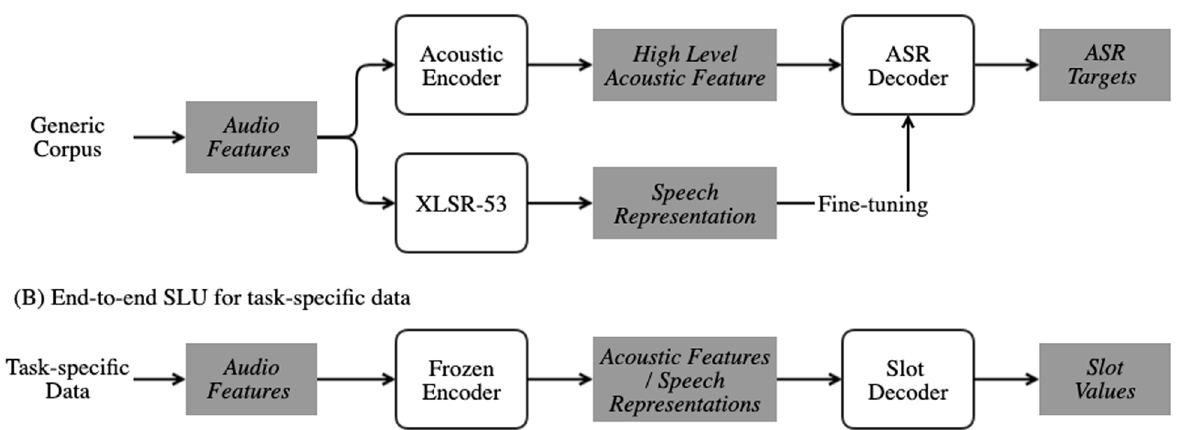
Fig. 1 Overall structure of the SLU system with pre-trained acoustic speech